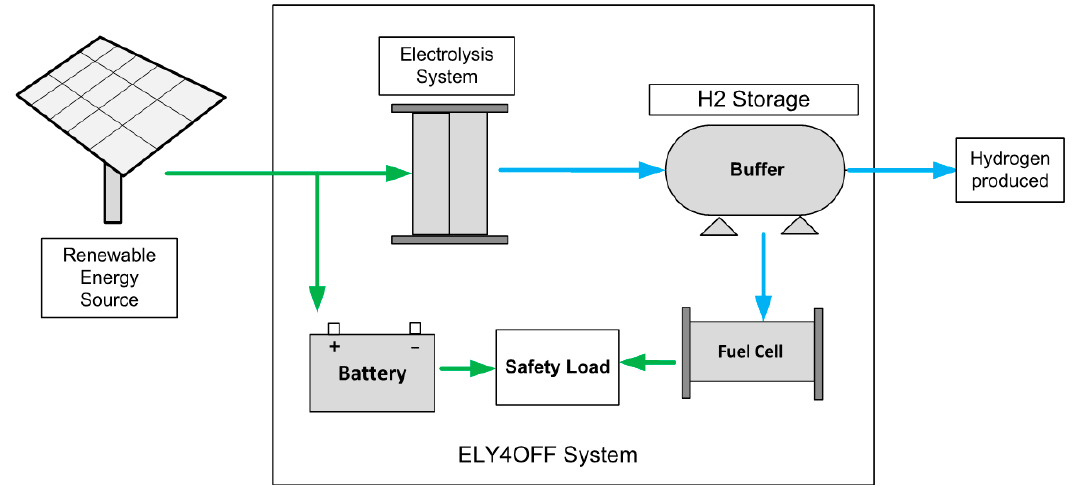
Figure 2. Ely4off configuration.